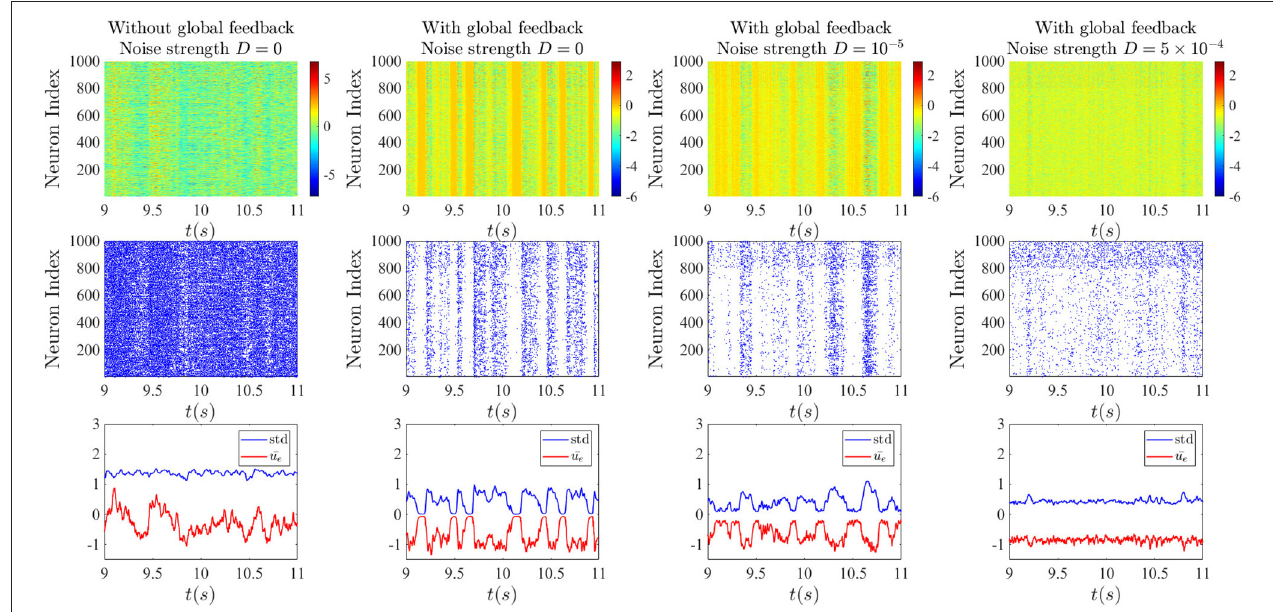
FIGURE 8 | Effect of noise on chaotic global activity dropouts. Top : Raster plots of neuron activities from simulations of Equations (1a) and (1b). Middle : Raster plots of neuron spiking obtained by applying the Poisson spiking rule Equation (3) to simulations in the top row. Bottom : time-dependent mean and standard deviation of the activities of units in the excitatory sub-network. In the left column, the noise and the global feedback are set to zero. In the second column, the global inhibitory feedback is added, leading to the random occurrence of epochs of strong synchrony due to activity dropouts. The last two columns correspond to the cases with additive weak and strong noise on the dynamics of the units. The global inhibitory feedback delay T is 10 ms and its strength κ is inhibitory sub-network exhibits qualitatively the same behavior as the excitatory one, but with a slightly higher spiking rate.